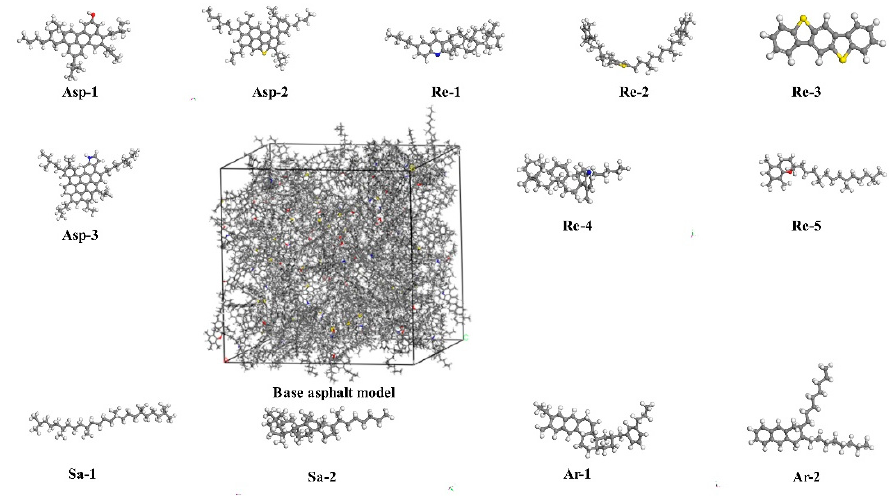
Figure 3. Molecular structure of base asphalt. Table 2. The SARA fractions of asphalt binder